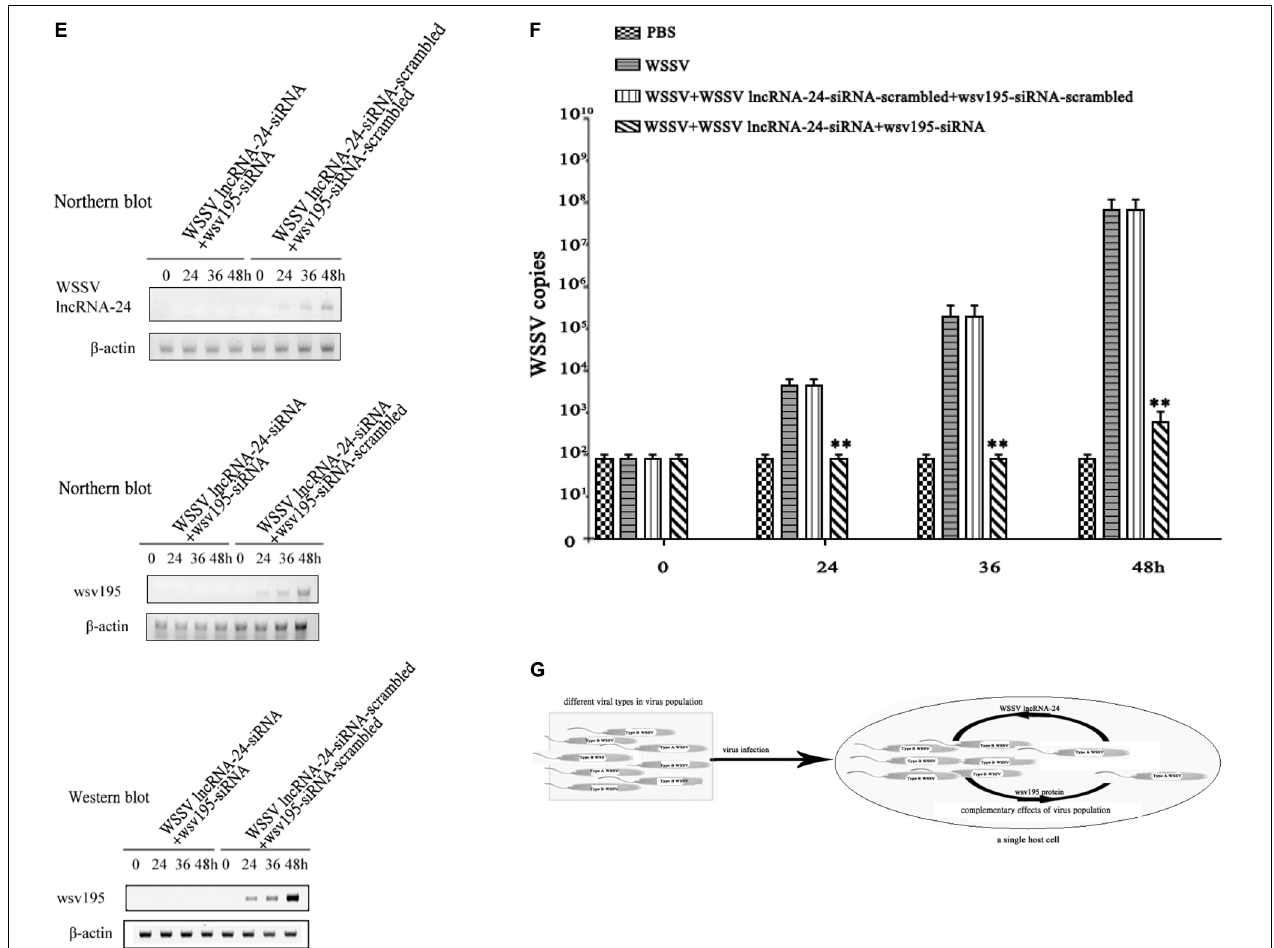
FIGURE 5 | Complementary effects of Type A WSSV and Type B WSSV in the virus population on virus infection. (A) Knockdown of WSSV lncRNA-24 encoded by Type A WSSV in shrimp. Shrimp were injected with WSSV lncRNA-24-siRNA or WSSV lncRNA-24-siRNA-scrambled. Twelve hours later, the shrimp were coinjected with siRNA and WSSV and then with siRNA three times at 12-h intervals. At different times after the WSSV injection, the expression levels of WSSV lncRNA-24 in shrimp haemocytes were examined by Northern blot analysis. β -actin was used as a control. (B) Influence of Type A WSSV on WSSV content in shrimp. Shrimp were injected with WSSV and WSSV lncRNA-24-siRNA. At different times post infection, the WSSV copy numbers in shrimp haemocytes were determined by quantitative real-time PCR. PBS, WSSV, and siRNA-scrambled were included in the assays as controls. The statistical significance between treatments is indicated with asterisks ( ∗∗ p < 0.01). (C) Silencing of wsv195 in shrimp. Shrimp were injected with wsv195-siRNA or wsv195-siRNA-scrambled. Twelve hours later, the shrimp were coinjected with siRNA (wsv195-siRNA or wsv195-siRNA-scrambled) and WSSV and then with the siRNA three times at 12-h intervals. At different times after the last injection, the expression level of WSSV lncRNA-24 in shrimp haemocytes was examined by Northern blot analysis (top) and Western blot analysis (bottom). Shrimp β -actin was used as a control. (D) Role of Type B WSSV in virus infection. Shrimp were injected with WSSV and WSSV wsv195-siRNA. At different times post infection, the WSSV copies in shrimp hemocytes were determined by quantitative real-time PCR. PBS, WSSV and siRNA-scrambled were used as controls. The statistical significance between treatments is indicated with asterisks ( ∗∗ p < 0.01). (E) Simultaneous depletion of Type A WSSV and Type B WSSV in WSSV-infected shrimp. Shrimp were injected with WSSV lncRNA-24-siRNA and wsv195-siRNA. Twelve hours later, the shrimp were co-injected with siRNAs (WSSV lncRNA-24-siRNA and wsv195-siRNA) and WSSV and then with the siRNAs three times at 12-h intervals. WSSV lncRNA-24-siRNA-scrambled and wsv195-siRNA-scrambled were included in the injection as controls. At different times after the last injection, the expression levels of WSSV lncRNA and wsv195 in shrimp haemocytes were examined by Northern blot and Western blot. Shrimp β -actin was used as a control. (F) Impact of simultaneous loss of Type A WSSV and Type B WSSV on virus infection in shrimp. Shrimp were co-injected with wsv195-siRNA, WSSV lncRNA-24 and WSSV. The WSSV content in shrimp was examined at different time after injection. The statistical significance between treatments is indicated with asterisks ( ∗∗ p < 0.01). (G) Model for the complementary effects of virus population during virus infection. All the experiments were biologically repeated for three